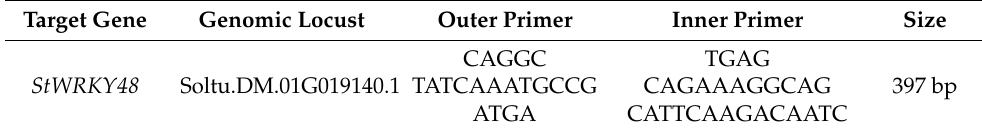
Table 4. The nested PCR primers for the miRNA cleavage sites’ validation by RLM-5 (cid:48) RACE. Target